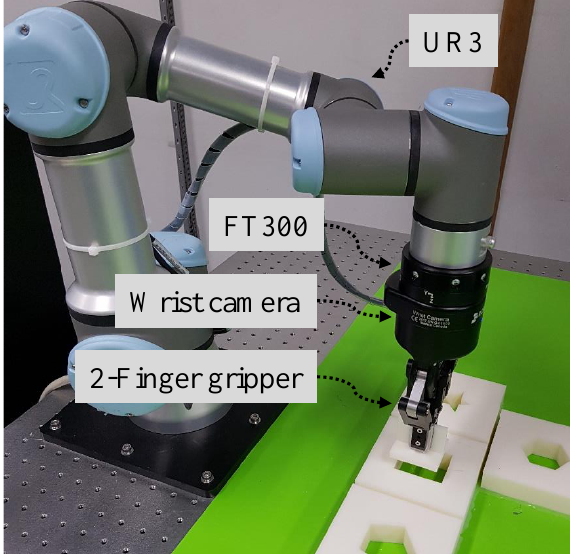
Figure 4. Experimental setup for peg-in-hole